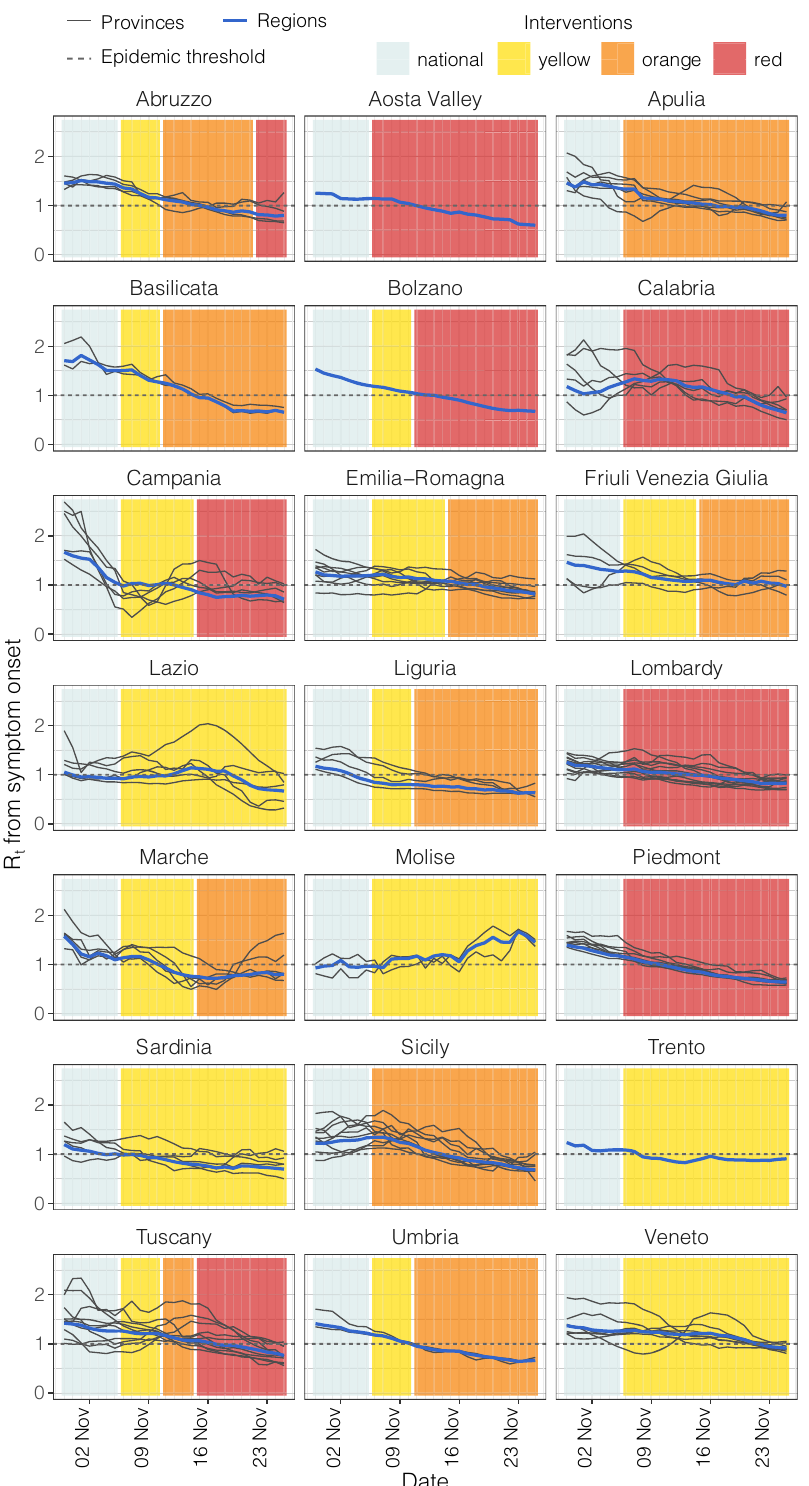
Fig. 2 Temporal dynamics of the net reproduction numbers R ( t ) and of the assigned tiers between October 30 and November 25. Each line shows the mean R ( t ) for an Italian province (black) or region (blue). Provinces are grouped by region as tiers were assigned on a regional basis. Colored rectangles refer to the timeframe when the different tiers were adopted: teal = national interventions, yellow, orange and red as the corresponding tier (see Table 1 for restrictions associated with the different